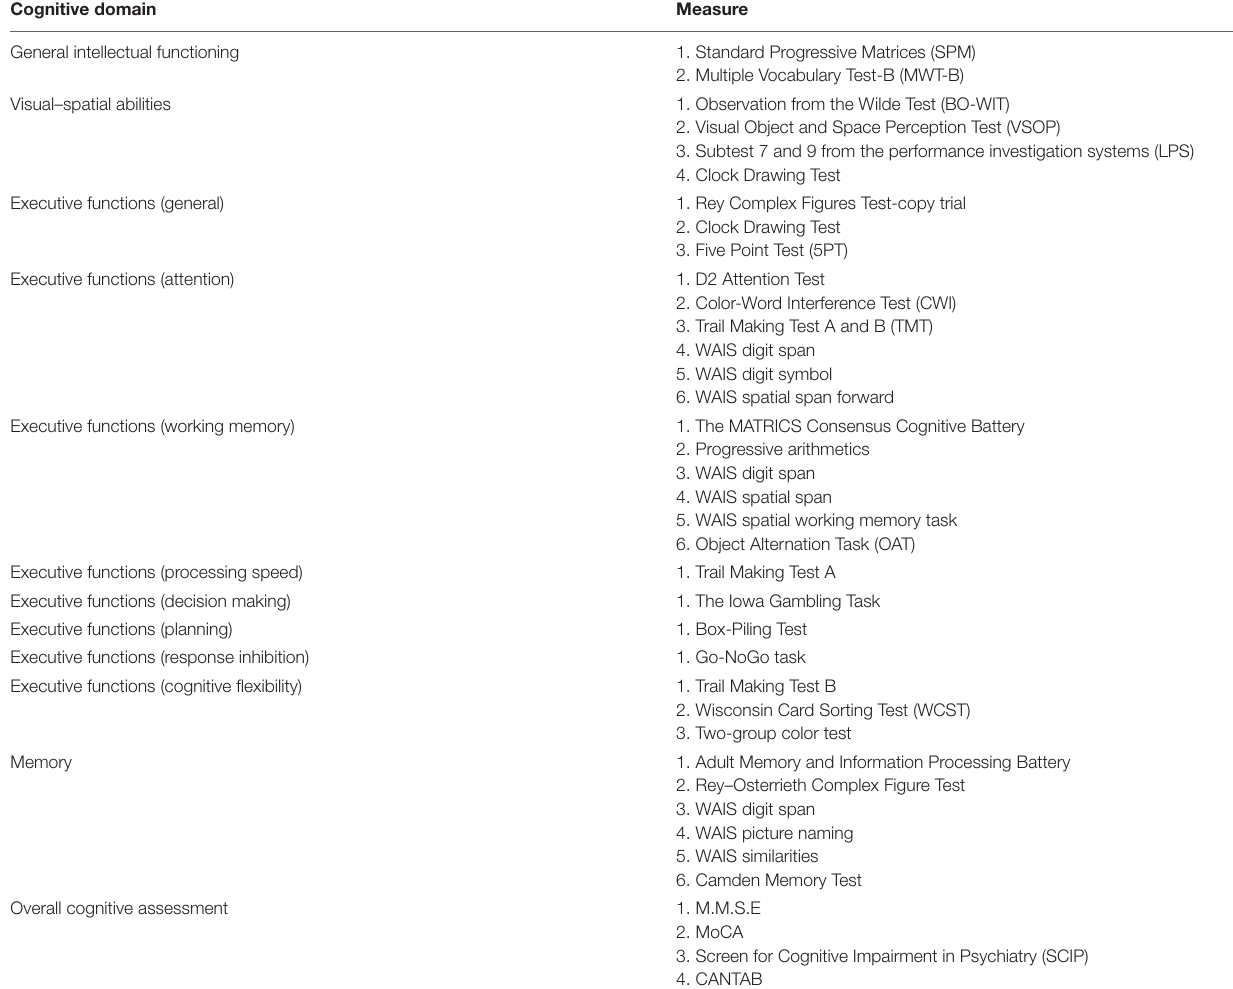
TABLE 4 | Neuropsychological tests used across cognitive